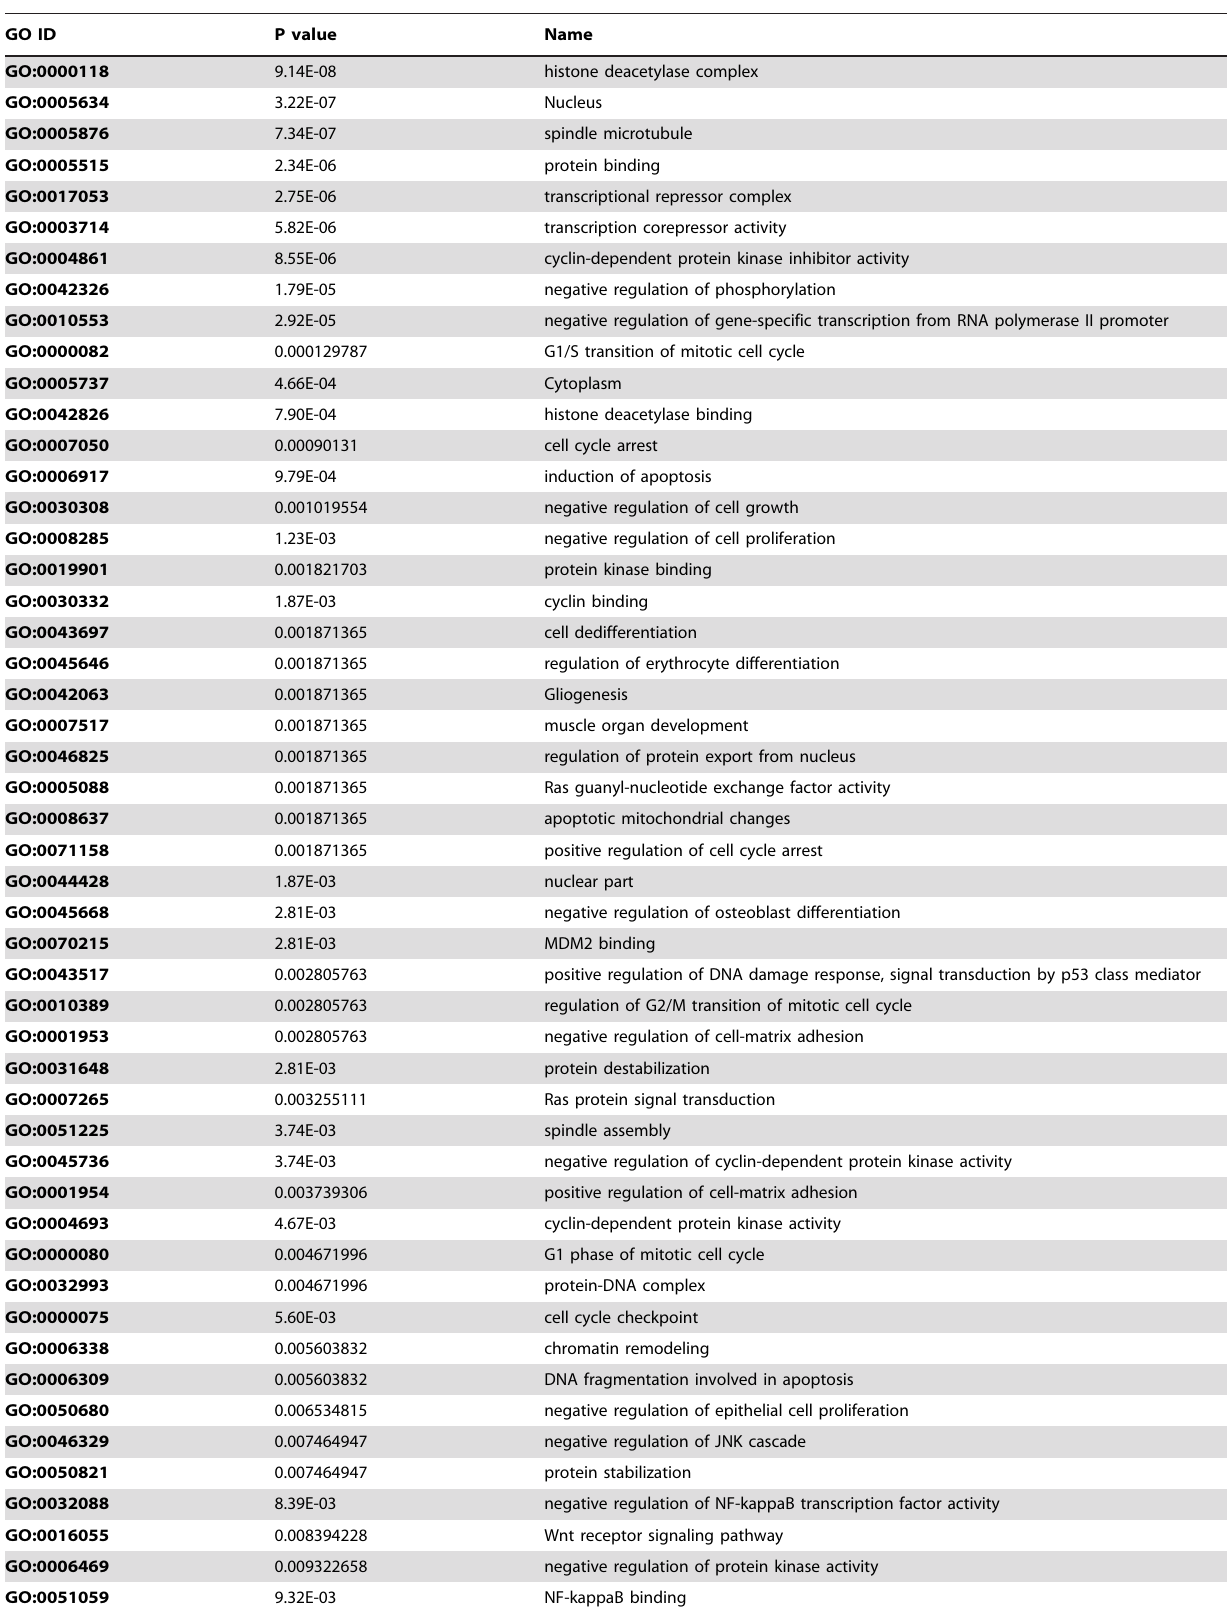
Table 3. Significant functions (P value , 0.01) of the progression-related sub network deregulated initially from BCLC stage 0